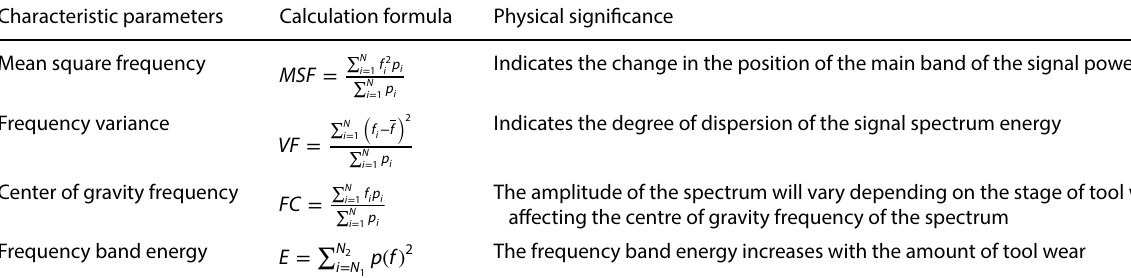
Table 4 Common time–frequency domain characteristics and calculation formulas Characteristic